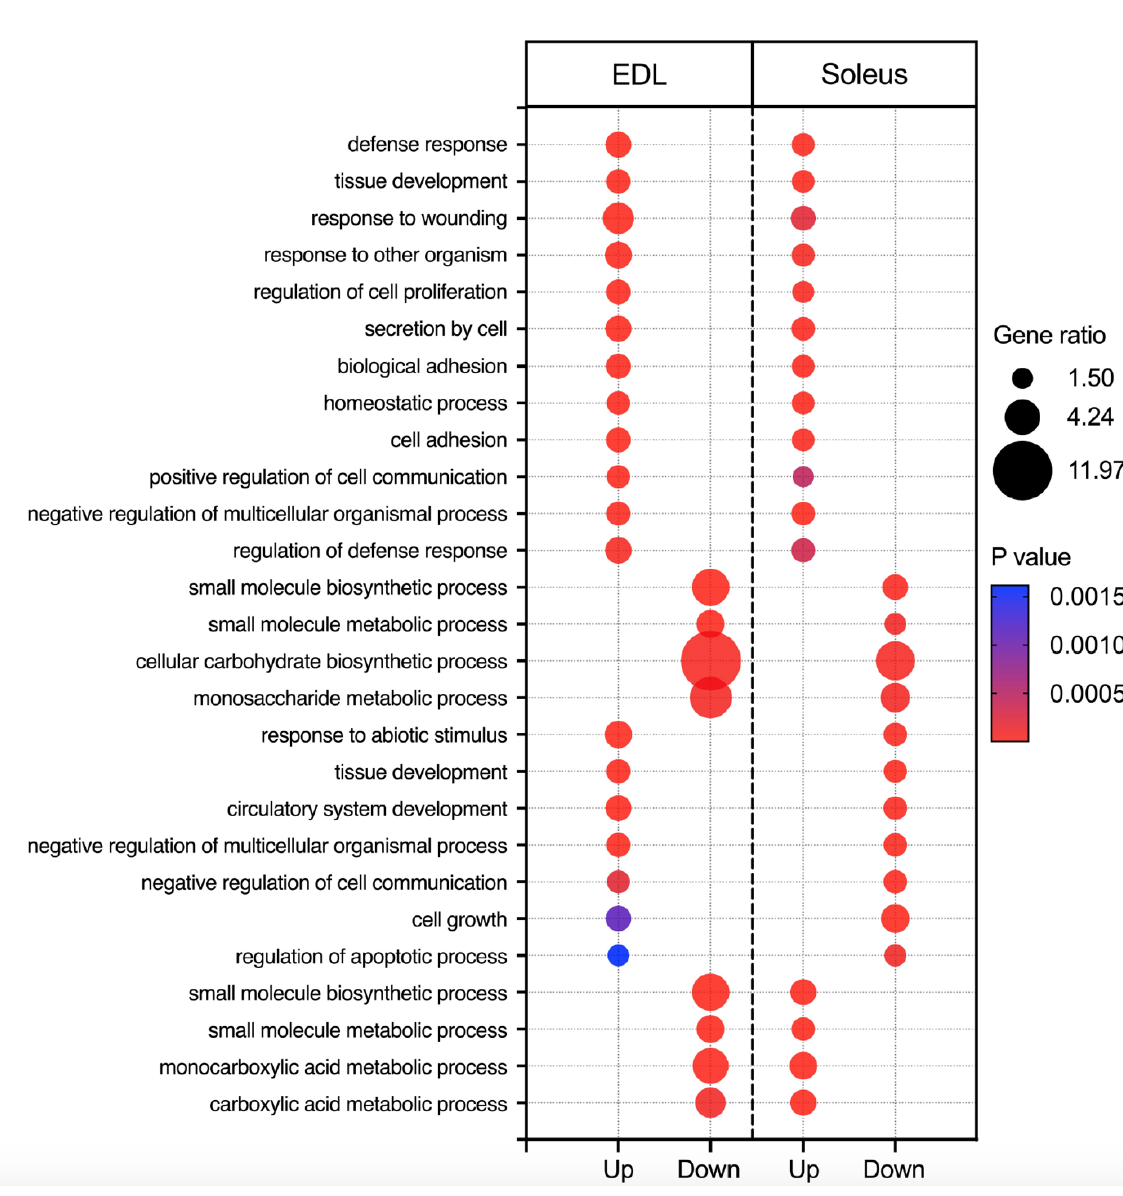
Figure 2. Shared upregulated and downregulated biological processes in soleus and EDL in response to spaceflight. The resulting gene ratio and p values from Webgestalt analysis of DEGs are shown.